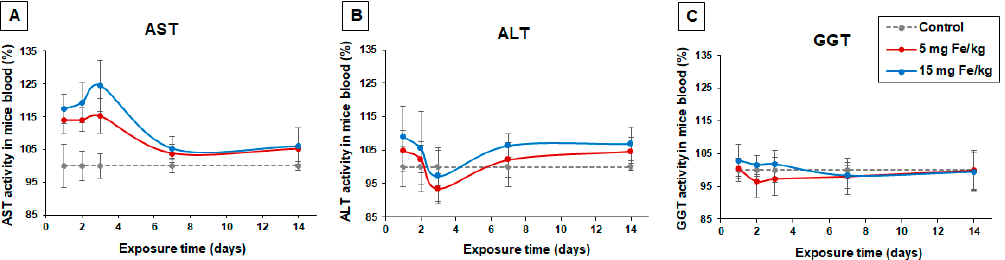
Figure 1. Effect of MNP-DSPE-PEG on the activity of some blood enzymes in the CD1 mice up to 14 d: ( A ) aspartate aminotransferase (AST), ( B ) alanine aminotransferase (ALT) and ( C ) Gamma-glutamyl transpeptidase (GGT). The results were expressed as mean ± standard deviation (SD) and represented as percentages related to the control group.